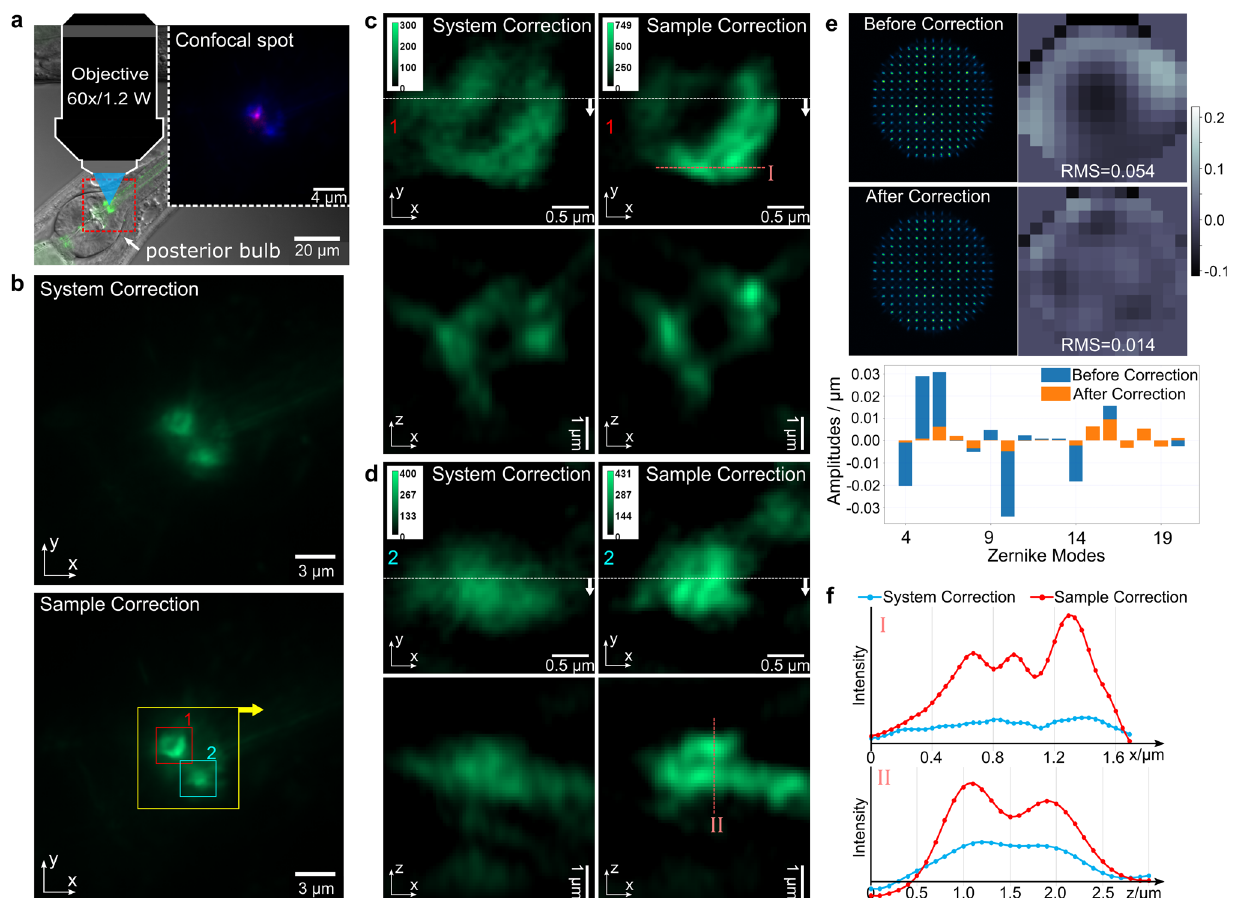
Fig. 8 Live C. elegans expressing the adherens junctions marker ajm-1 ::GFP. a The image overlay of a fl uorescence image and a DIC phase image to illustrate the location of the AJs in the posterior bulb of the pharynx and the image of the fl uorescent confocal spot (inset). b Wide fi eld images of AJs in the posterior bulb of the pharynx before and after sample correction. c 3D-SIM image of AJ 1 (inside red square) before and after sample correction, including the in-focus x-y slices and x-z slices cut through the dotted white lines. d 3D-SIM image of AJ 2 (inside blue square) before and after sample correction, including the in-focus x-y slices and x-z slices cut through the dotted white lines. The images of the same area are set in the same intensity scale. e Focal spot array captured on the SHWFS, the measured wavefront before and after sample correction, and the Zernike mode decompositions of the measured wavefront. Units in microns. f Intensity pro fi le plotted across the red dashed lines along both the x and z axis in 3D-SIM